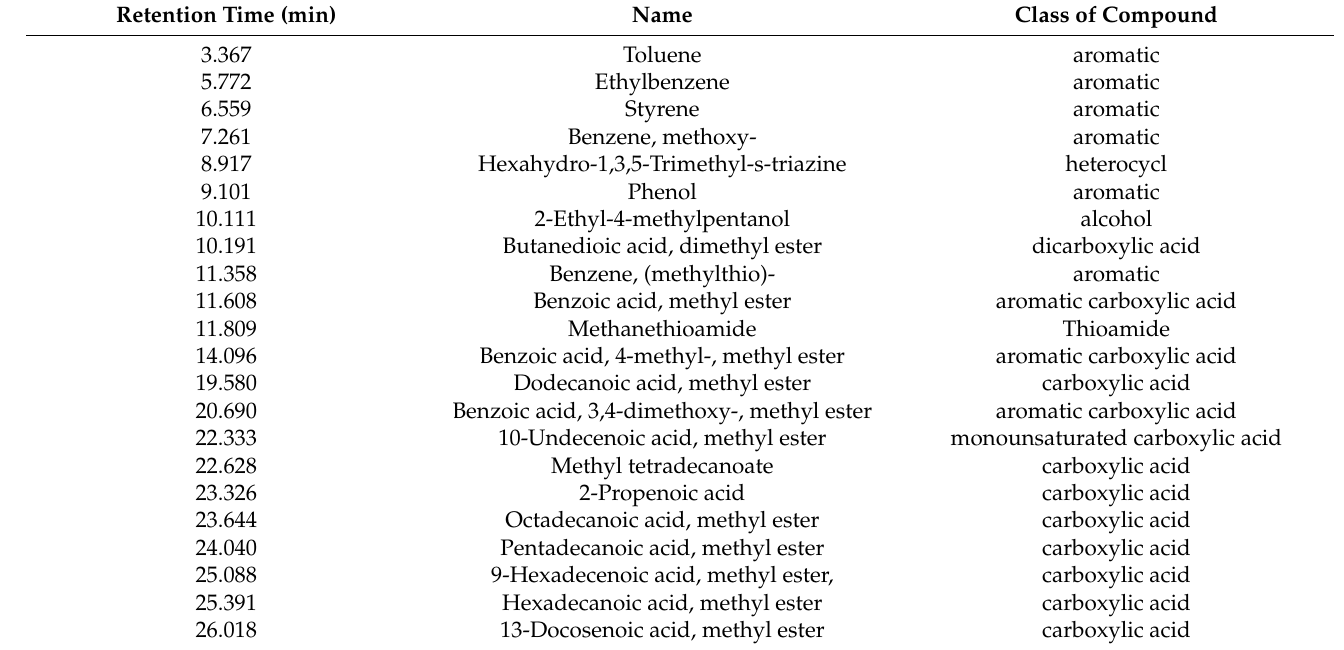
Figure 7. Pyrogram obtained from the Py-GC-MS process of FA extracted from Fiuggi water. The analyzed samples were characterised (Table 5) by the presence of aliphatic compounds, methyl esters of C7–C18 monocarboxylic acids (both saturated and unsaturated), C4–C9 dicarboxylic acids (a small amount of which were unsaturated), phenol methyl ethers, sulphur, and nitrogen compounds of the same type as those found in the aqueous fractions. Table 5. Compounds identified by Py-GC-MS.